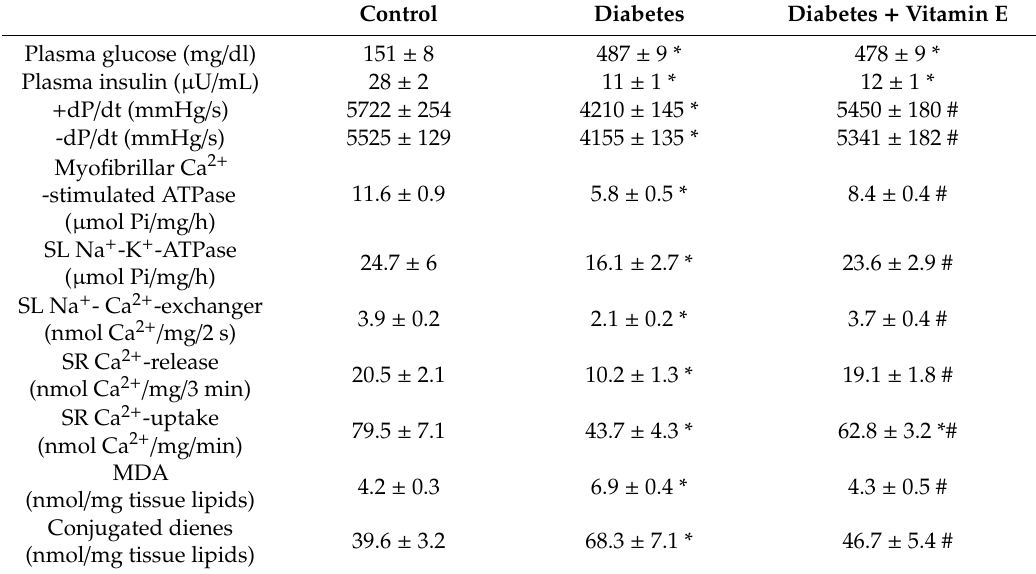
Table 6. Glucose / insulin levels, hemodynamic parameters and subcellular activities in control, STZ-induced diabetic and diabetic animals treated with vitamin